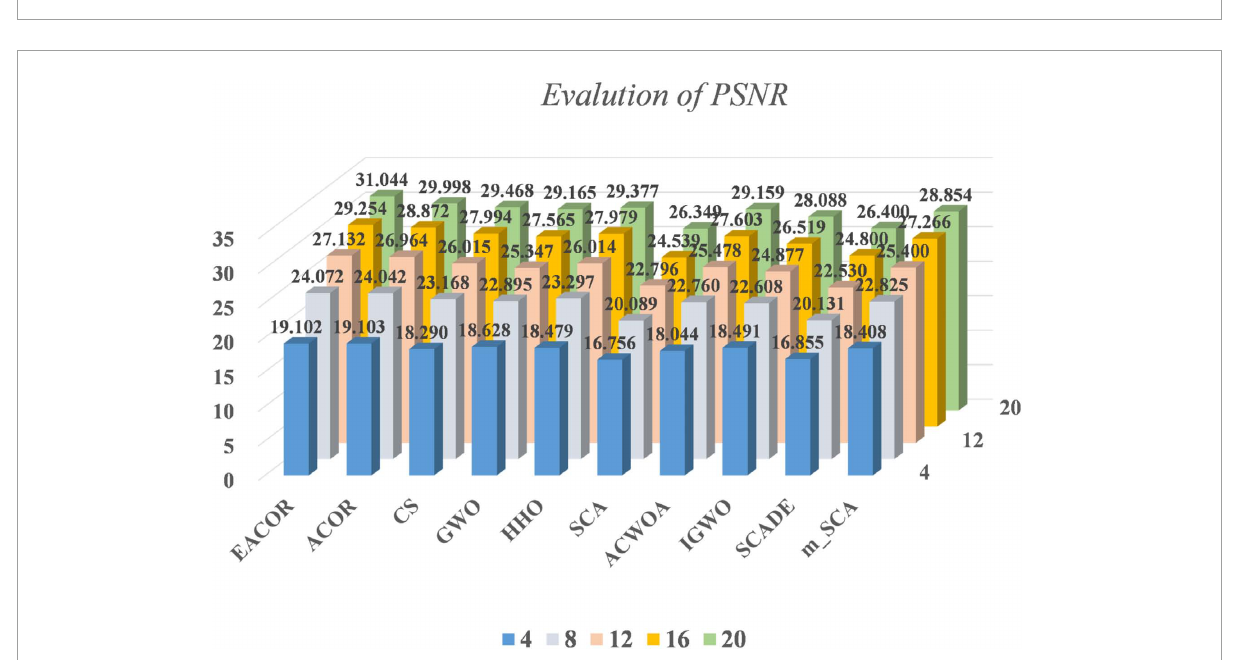
FIGURE13 FSIM results at different thresholds for nine melanoma images.